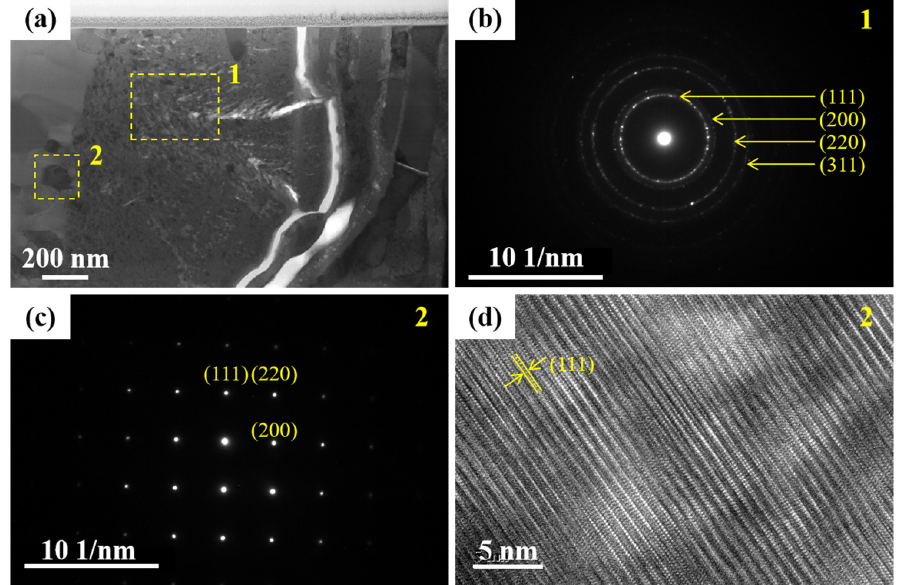
Figure 6. TEM image: ( a ) bright field image of Gd 2 Zr 2 O 7 coating; ( b ) the SAED patterns of Gd 2 Zr 2 O 7 coating the areas marked 1 in ( a ); ( c ) the SAED patterns of Gd 2 Zr 2 O 7 coating the areas marked 2 in ( a ); ( d ) HRTEM image of Gd 2 Zr 2 O 7 coating the areas marked 2 in ( a ).